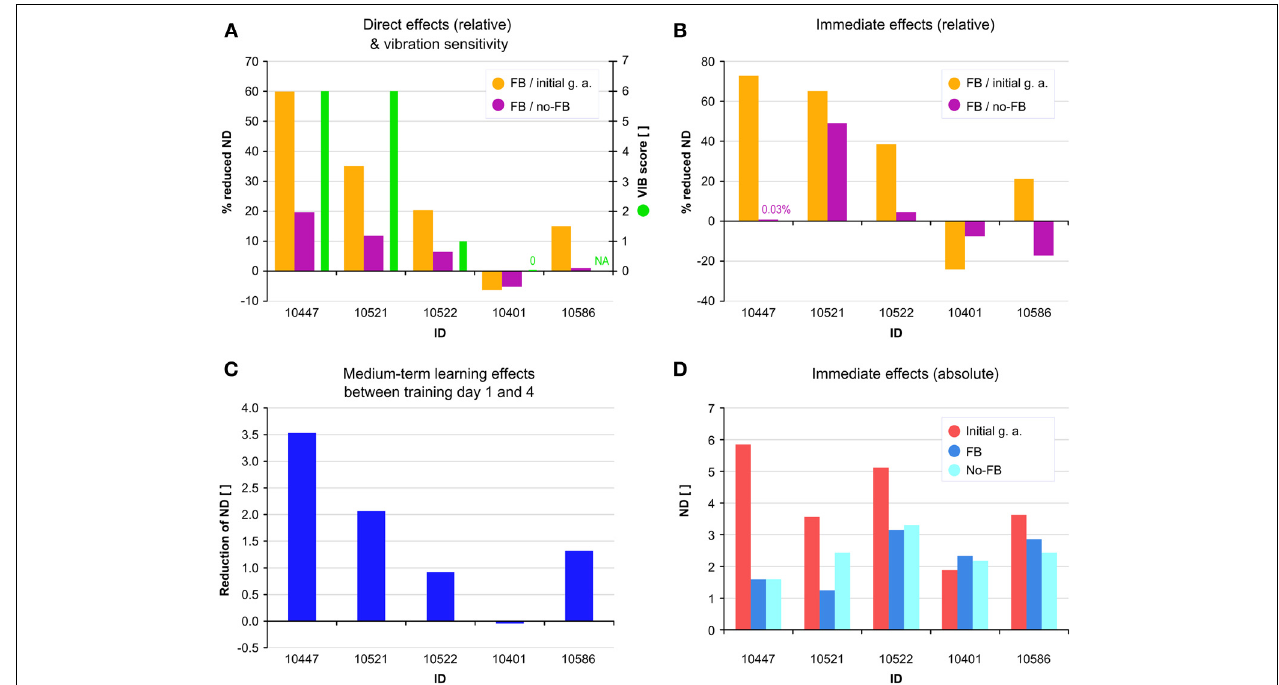
FIGURE 6 | (A) Direct effects of feedback FB as reduced norm distance (ND) during all FB sessions relative to all initial gait analyses (orange) and relative to all no-FB sessions (purple). Vibration sensitivity (VIB) score is displayed as green bars. (B) Immediate effects of FB during the first FB session relative to the first initial gait analysis (orange) and